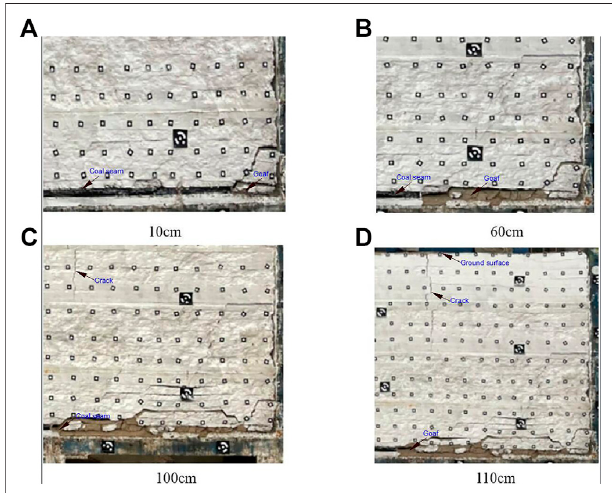
FIGURE 7 | Breakage states of rock strata of the physical model in different